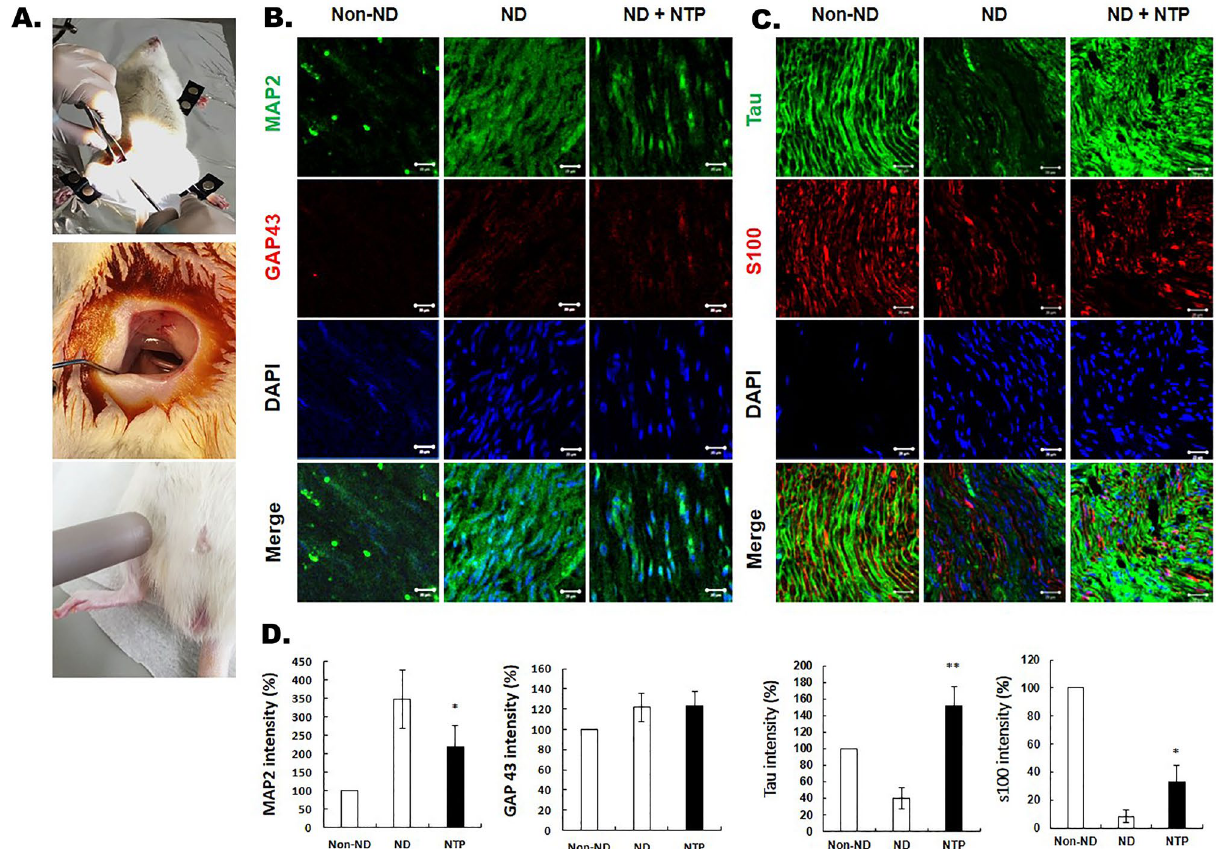
Figure 6. Animal experiments and results. ( A ) Image of surgery for anastomosis of cut sciatic nerve and NTP treatment of the damaged nerve in the rat model. NTP was applied 0.5 cm away from the skin overlying the sciatic nerve for 5 min. ( B ) and ( C ) Immunofluorescence of neural tissue in the three groups and quantitative analysis: MAP2, GAP43, tau, S100B, and DAPI. Representative photographs of each group were taken using confocal microscopy. *Scale bars = 20 μm. *Indicates p ≤ 0.05, ** indicates p ≤